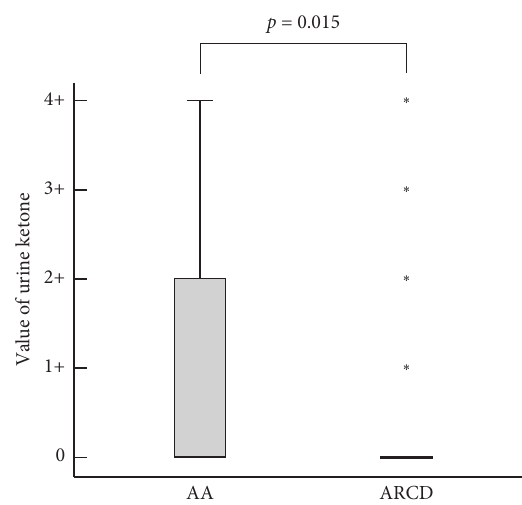
Figure 1: Boxplot showing urine ketone values from dipstick tests for acute appendicitis and acute right-sided colonic diverticulitis